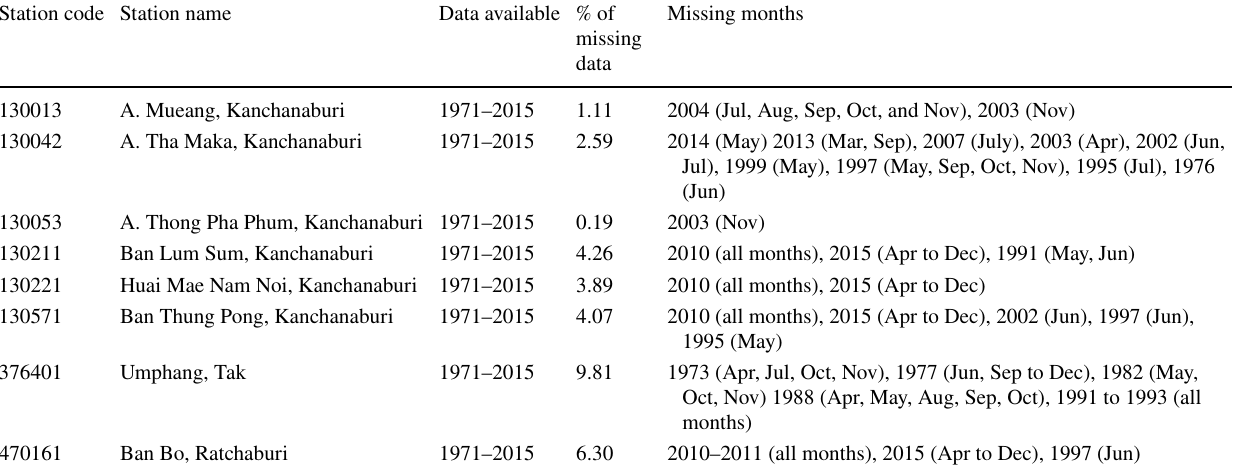
R o = Observed rainfall. b: Slope of graph to which records are adjusted. a: Slope of graph at time R o was observed.